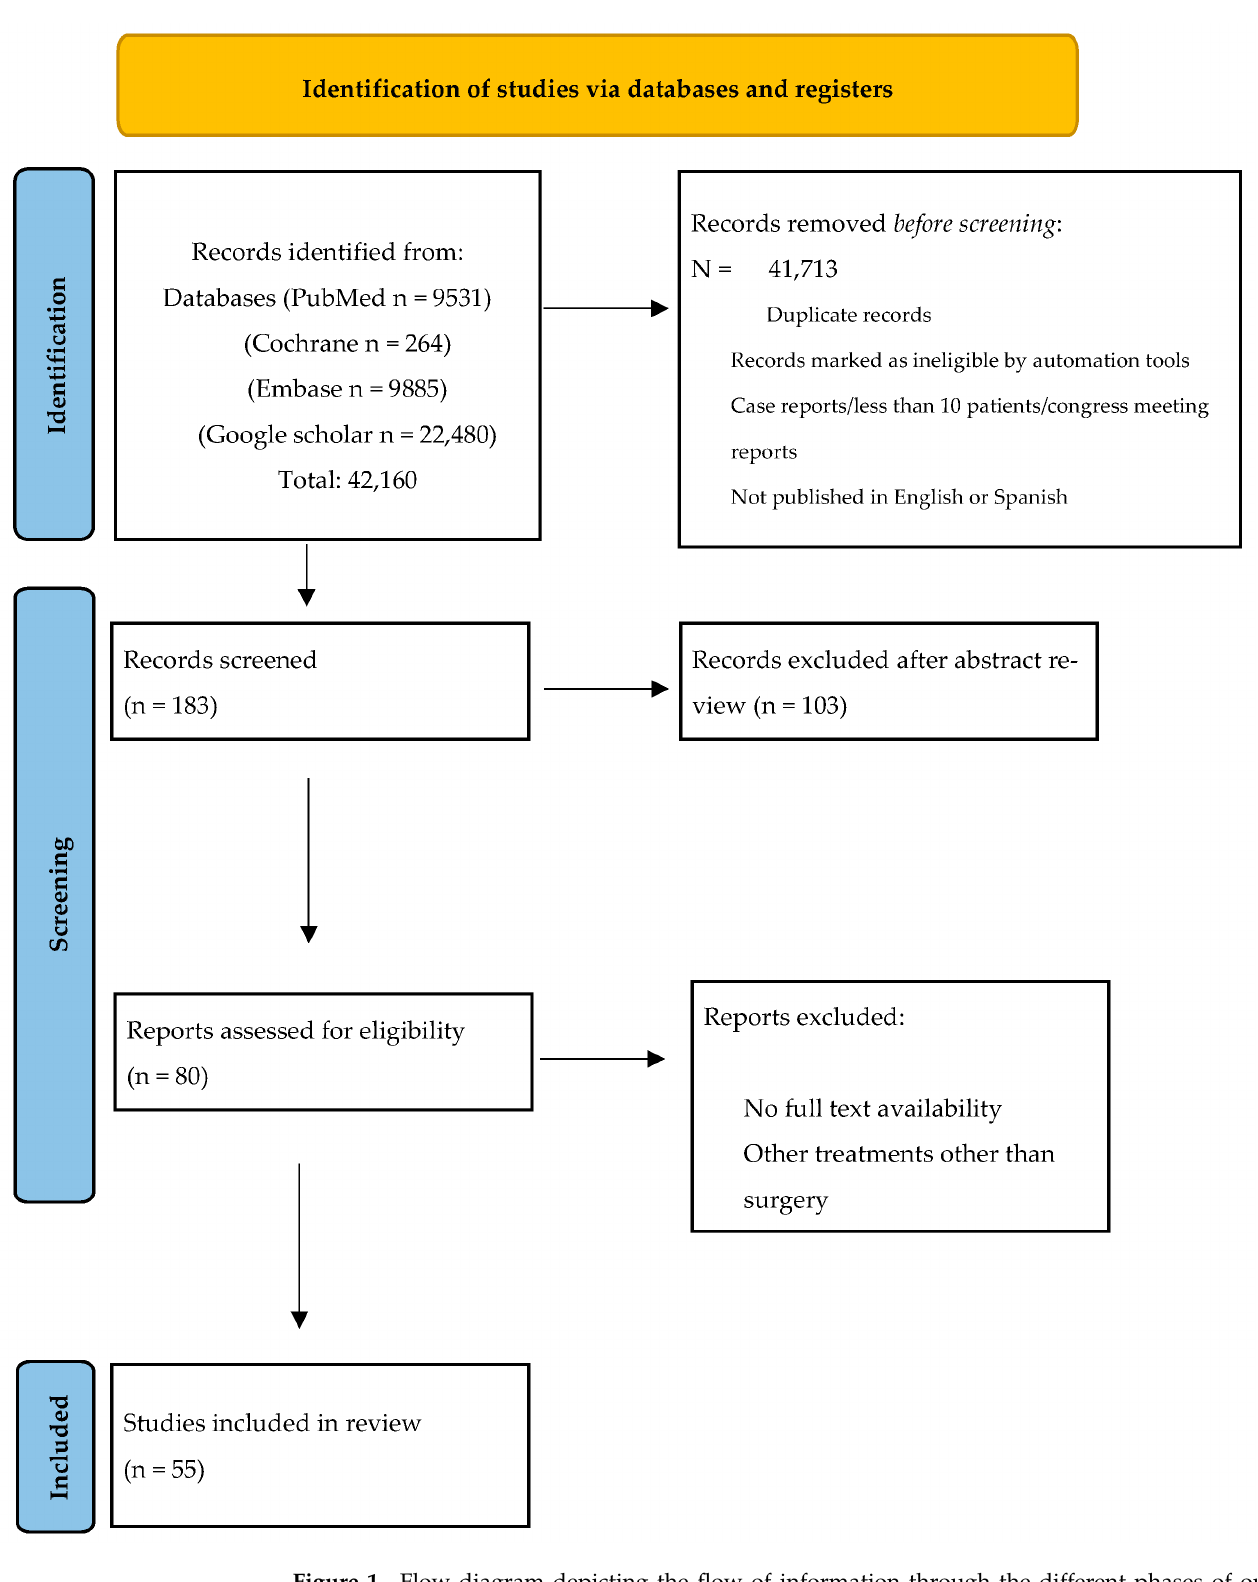
Figure 1. Flow diagram depicting the flow of information through the different phases of our systematic review. PRISMA, Preferred Reporting Items for Systematic Reviews and Meta-Analyses.